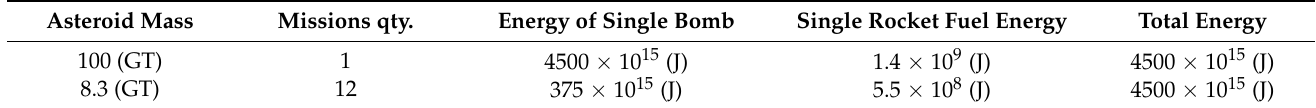
Table 3. Energy costs for launching the nuclear bomb into asteroids from Kuiper belt. Asteroid Mass Missions